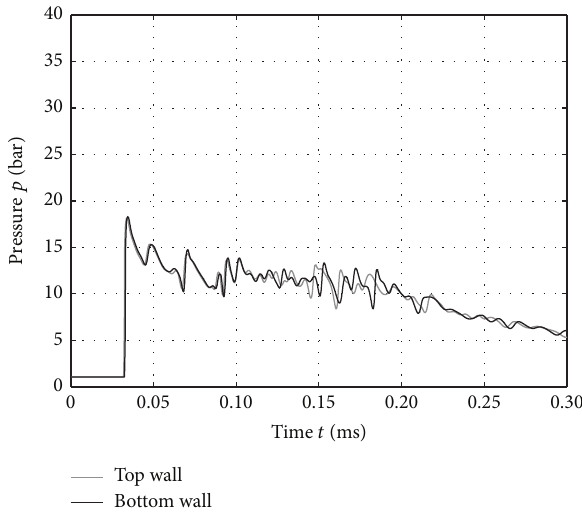
Figure 14: Pressure records from a steadily propagating detonation in a mixture with 25% H 2